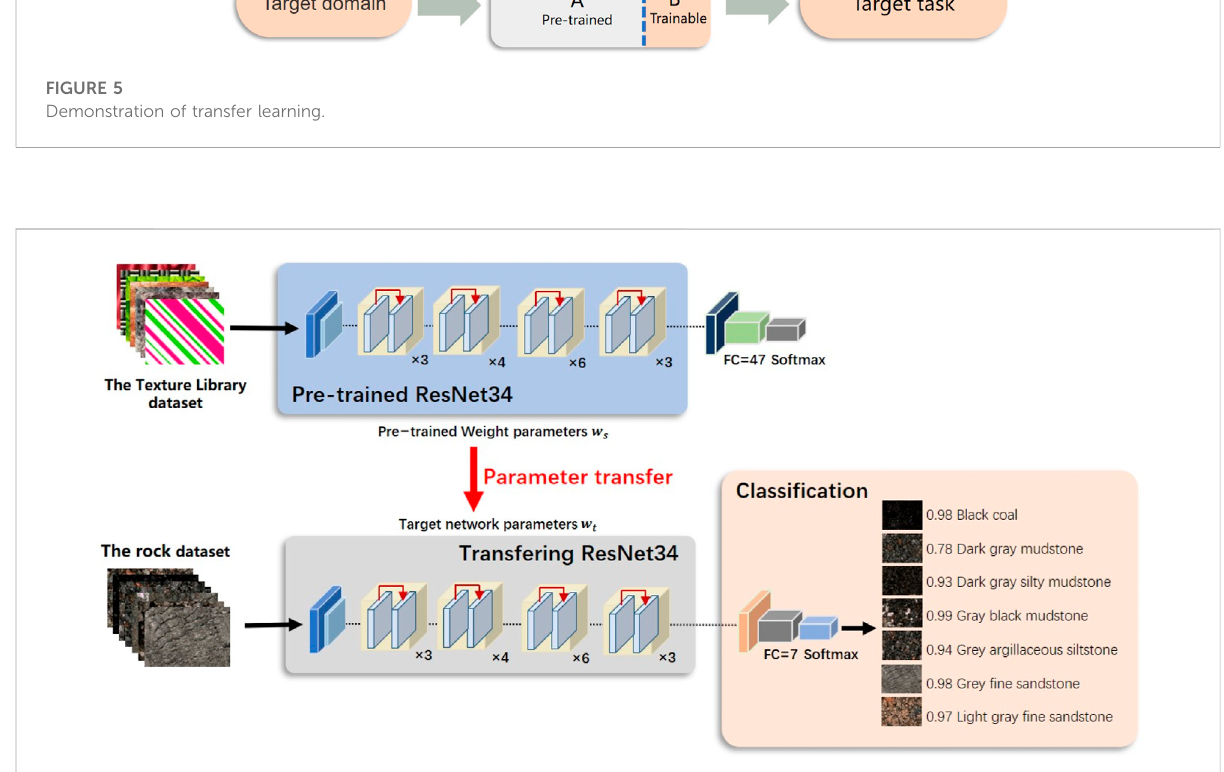
FIGURE 6 Schematic diagram of transfer learning in rock classi fi